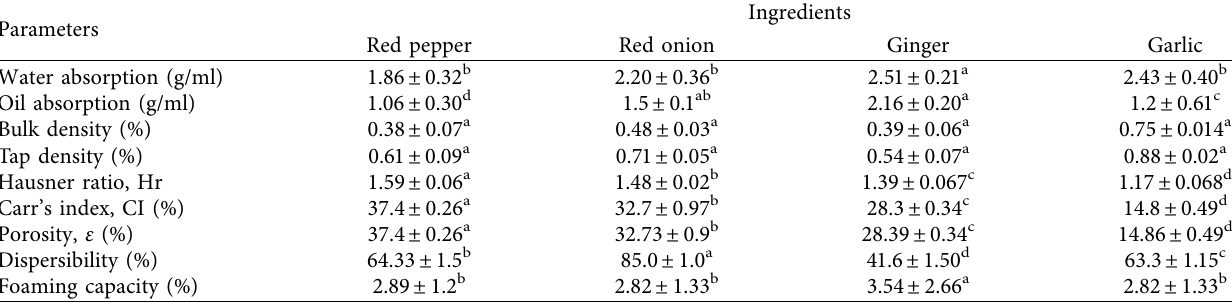
Table 3: Functional properties of the powders of red pepper, red onion, ginger, and garlic. Parameters